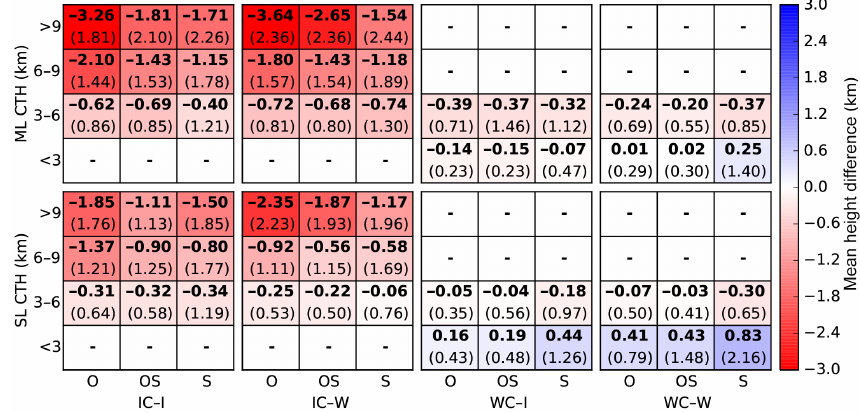
Figure 3. Mean CTH differences between the three algorithms and CALIOP where the ORAC and ORAC + stereo phases agree (standard deviation is included in the brackets). The codes employed in the table are as follows: O: ORAC; OS: ORAC + stereo; S: stereo; IC: ice cloud; WC: water cloud; I: ice-covered surface; W: water-covered surface; SL: single-layer cloud; and ML: multi-layer